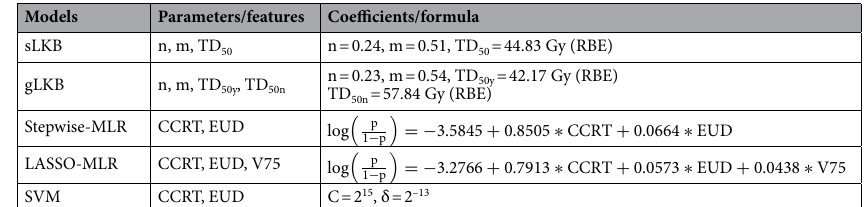
Table 2. Feature selection results and parameter values for sLKB, gLKB, Stepwise-MLR, LASSO-MLR, and SVM models. sLKB standard Lyman–Kutcher–Burman, gLKB generalized Lyman–Kutcher–Burman,